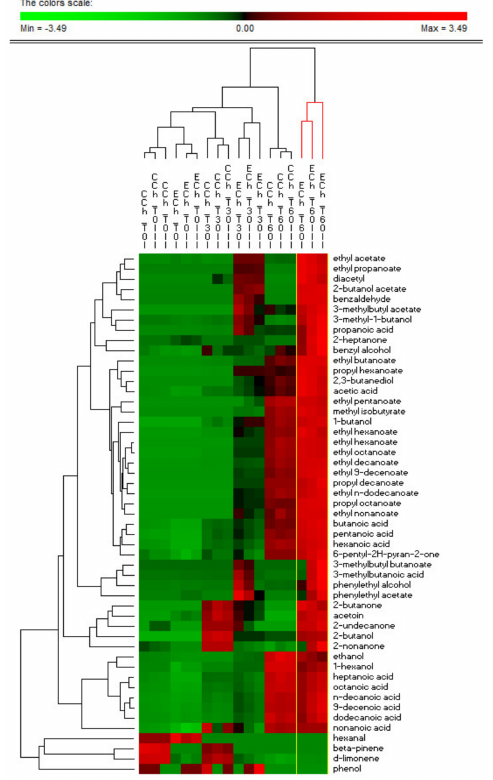
Figure 3. Grouping of samples based on the volatile organic compounds (VOCs) identified in experimental (ECh) and control (CCh) cheeses at 0, 30 and 60 days of ripening. The different batch of cheeses are indicated as I, II and